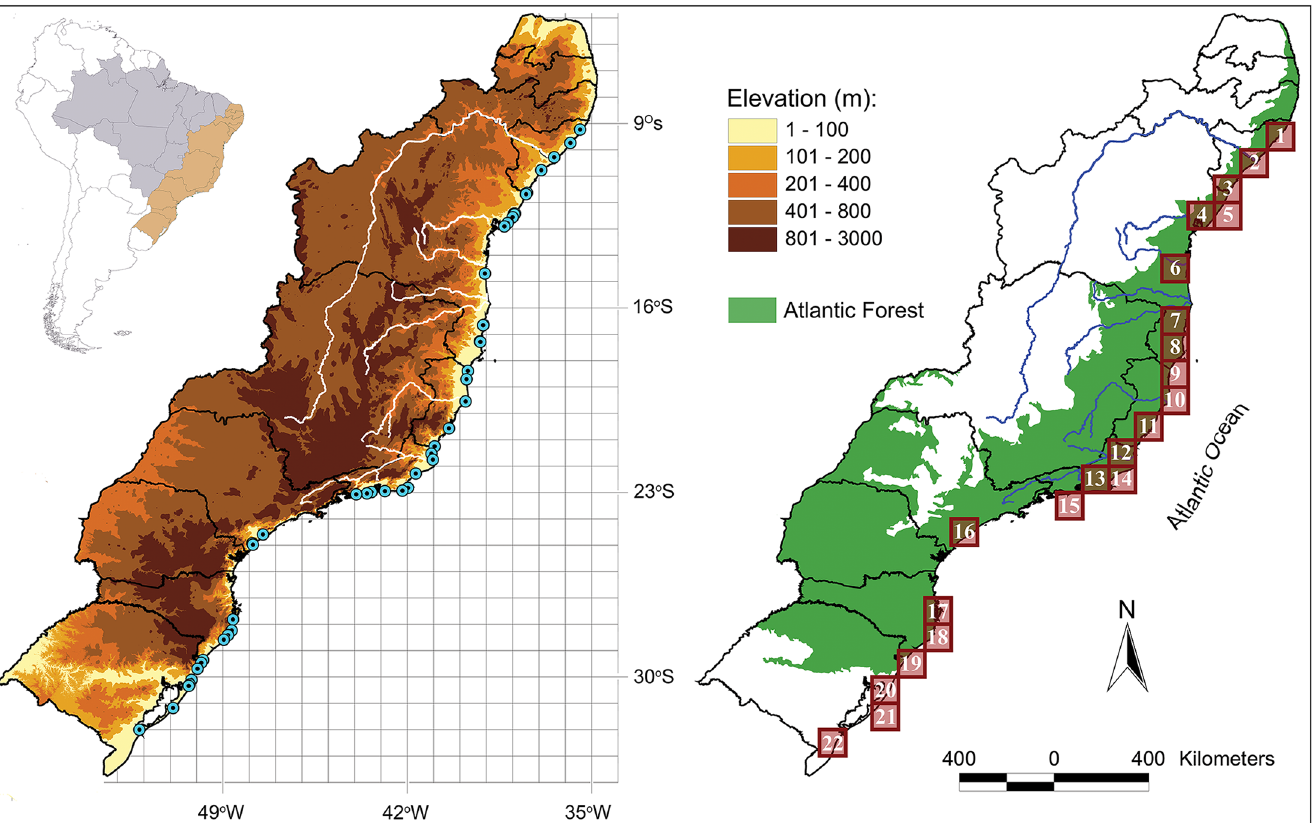
Fig 2. Maps showing the area of study. On left, topographic map showing the point locality sampling of anurans along the Restingas. Right, distribution map of the 22 quadrats considered for the